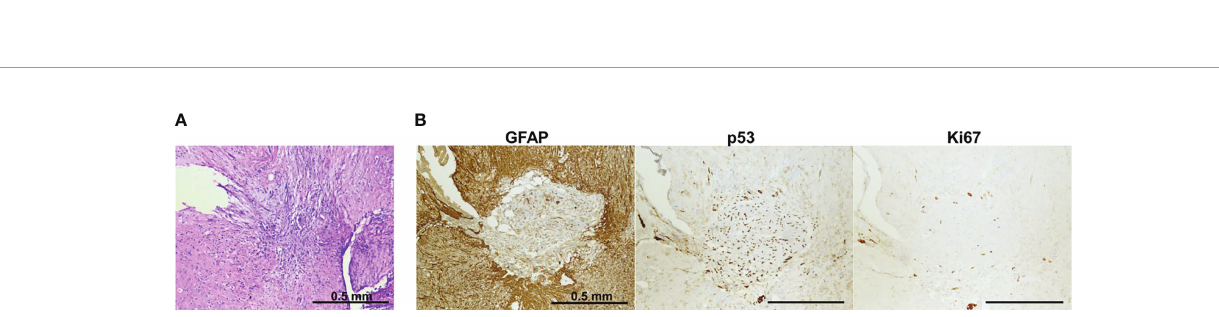
FIGURE 5 | H&E staining of original patient ’ s tumor (A), dual-labeled human GBM (B) , and U87 MG (C) xenografts. Enlarged regions are indicated by the black squares on the lower-magni fi cation panel. Bars are applicable to all images in the